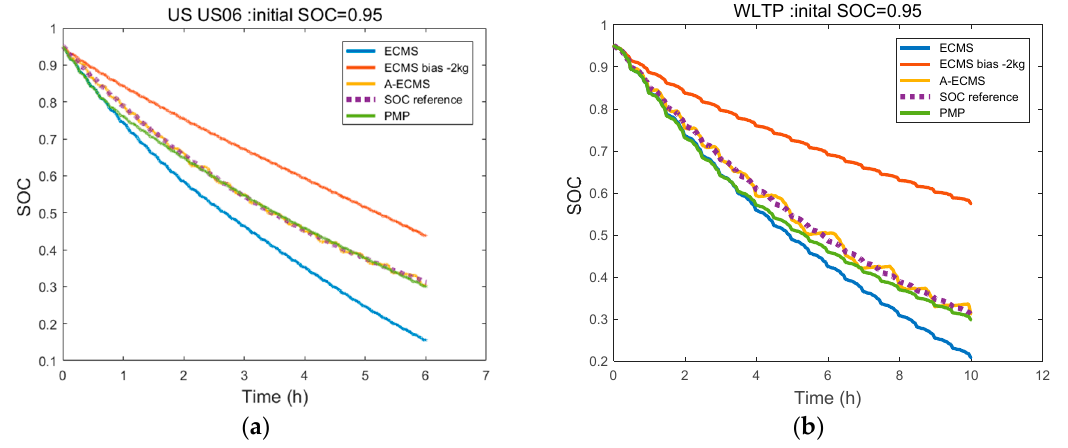
Figure 15. The strategies verified in standard driving cycles :( a ) US_US06 ;( b ) WLTP.